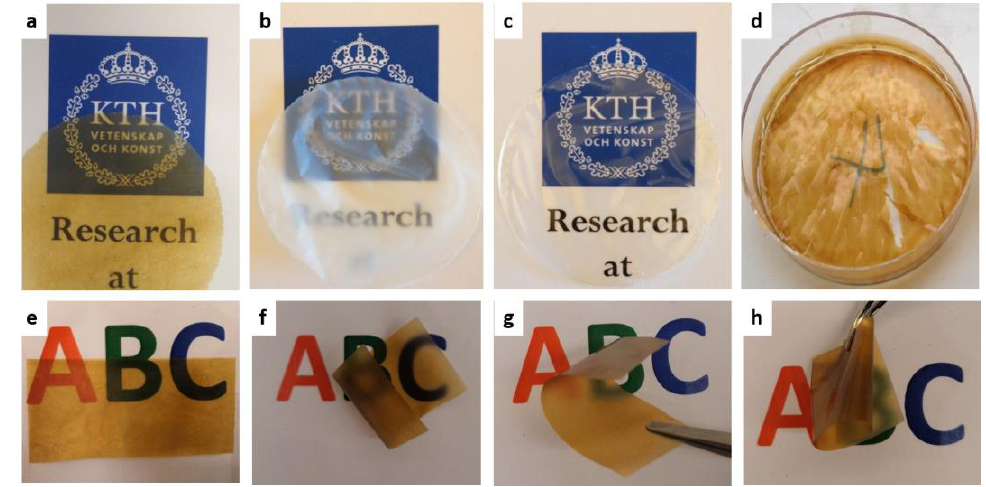
Figure 3. Photos of neat films and composite films made of starch, CNF and lignin. ( a ) SCL25 composite film, ( b ) CNF film, ( c ) starch film, and ( d ) no film formation for SL20, SL30 and SL40; ( e – h ), the flexibility and foldability of the SCL25 composite film.